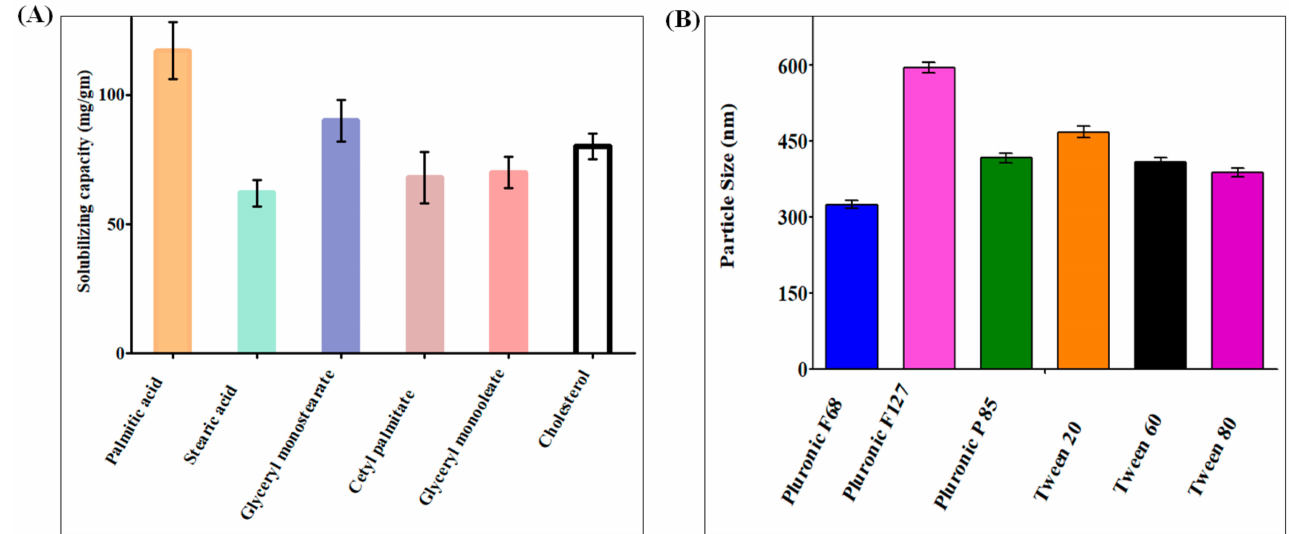
Figure 1. ( A ) Solubilizing capacity of DATS in palmitic acid, stearic acid, glyceryl monostearate, glyceryl monooleate, acetyl palmitate, and cholesterol. The data show that DATS had the highest solubilizing capacity in palmitic acid. ( B ) DATS SLNs was developed using Pluronic F-68, Pluronic F-127, Pluronic P-85, Tween 20, Tween 60, and Tween 80. The graphical data indicate that Pluronic F68 was the most suitable surfactant to produce minimum